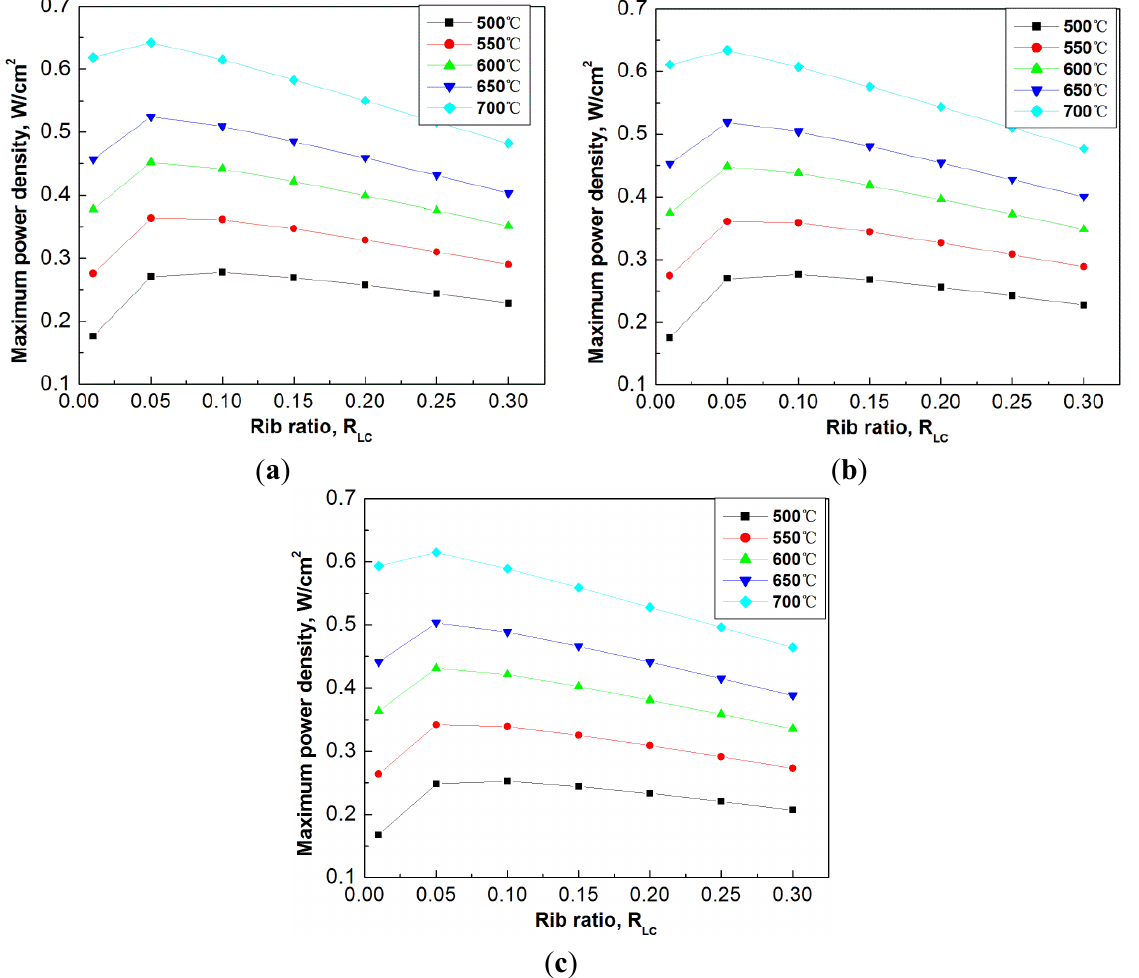
= 1.5 mm; ( b ) L = 3.0 mm; ( c ) L = 4.5 mm. o o o